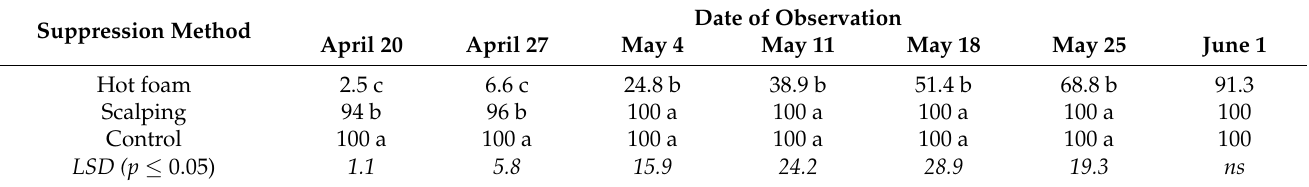
Table 3. Green cover (%): mean effect of Lolium perenne suppression method.